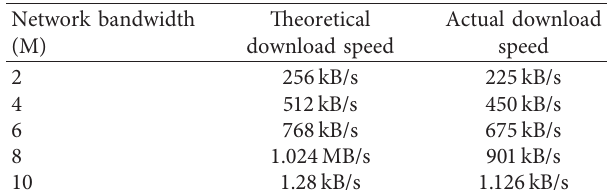
Table 2: Relationship between network bandwidth, theoretical download speed, and actual download